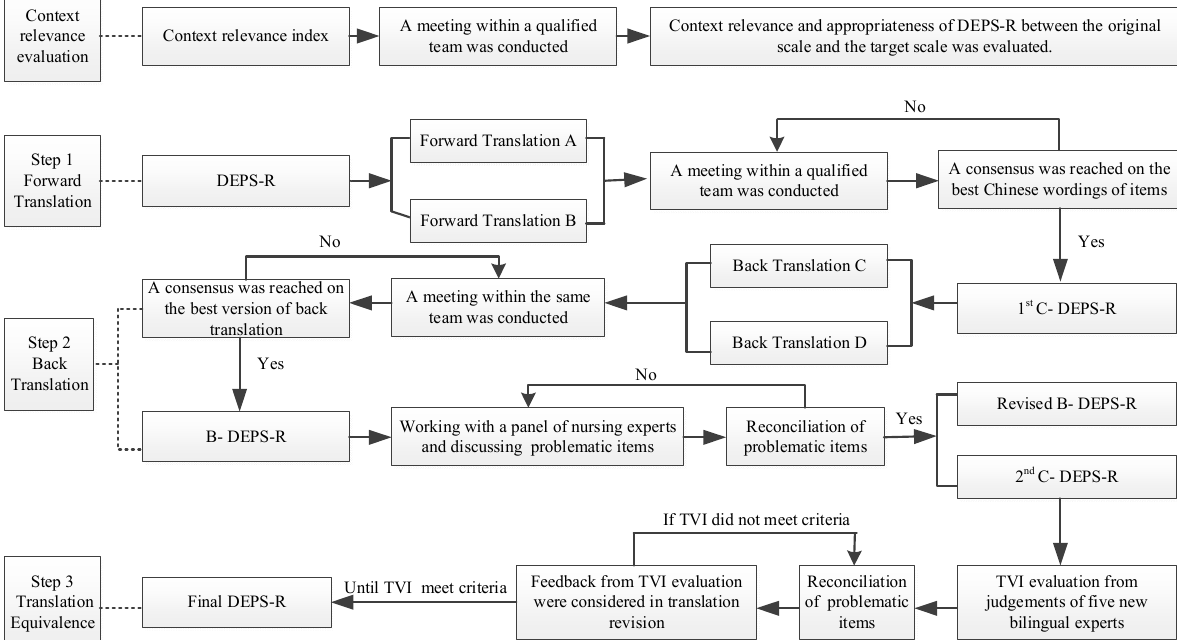
Figure 1. Context relevance evaluation and instrument translation procedure of DEPS-R. Note. DEPS-R, the original English version of the Diabetes Eating Problem Survey-Revised; C-DEPS-R, the translated Chinese version of the Diabetes Eating Problem Survey-Revised; B-DEPS-R, the back-translated version of the Diabetes Eating Problem Survey-Revised (in English); TVI, translation validity index.